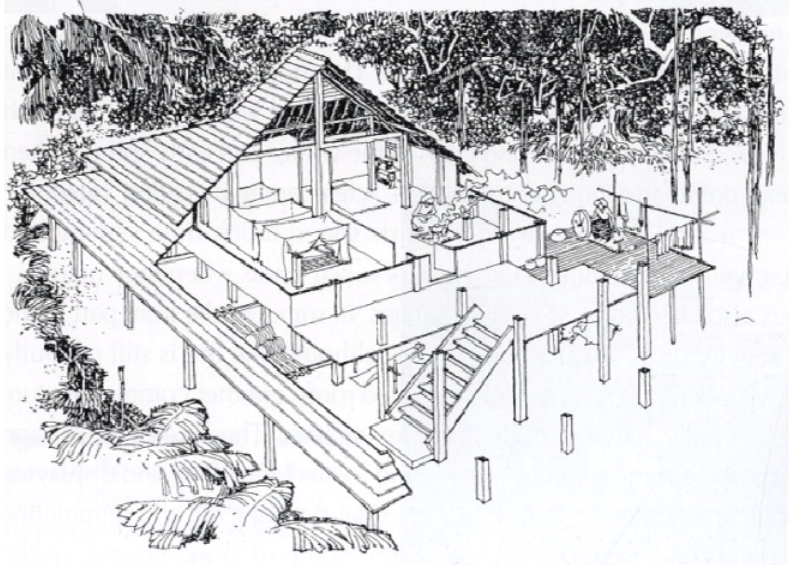
Figure 21. Wooden storied house drawing